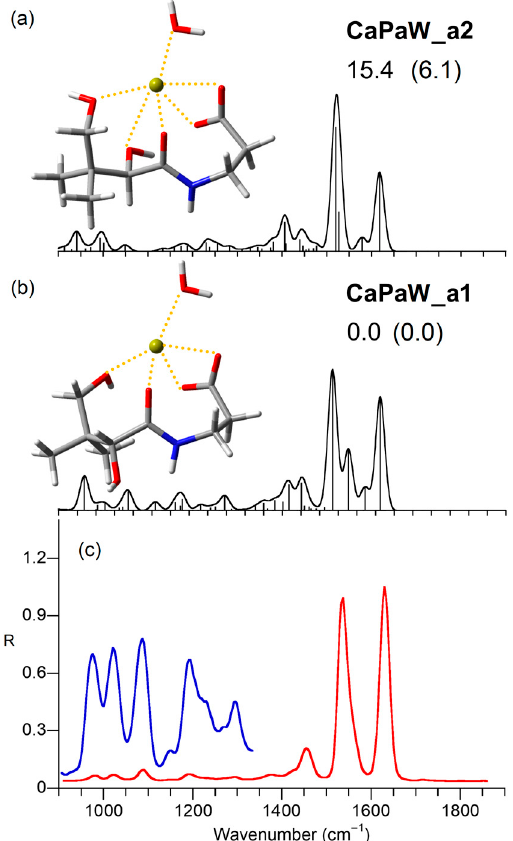
Figure 6. ( c ) Experimental IRMPD spectrum of [Ca(panto-H)(H 2 O)] + (bottom, colored profiles) and computed IR spectra of isomers ( b ) CaPaW_a1 and ( a ) CaPaW_a2 obtained at the B3LYP level. Optimized structures at the B3LYP level are reported together with free energies at 298 K in kJ mol − 1 computed at the B3LYP and MP2 level (in parentheses).